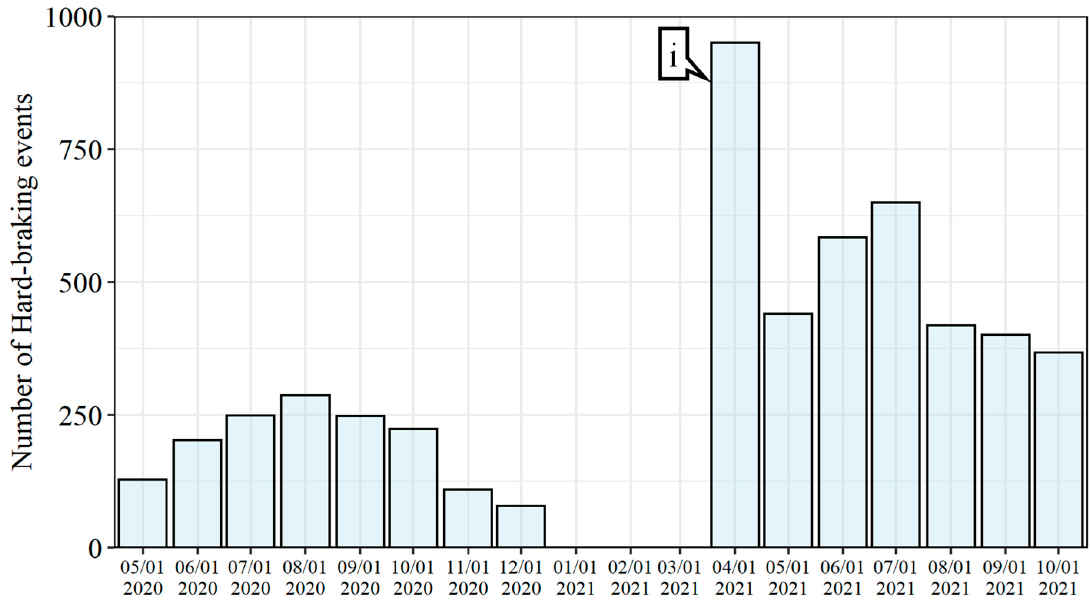
Figure 15. Interquartile speeds for 0.1-mile segments during and after the lane shift on I-65 NB. ( a ) Speeds during the lane shift (Monday, 12 April–Sunday, 18 April 2021); ( b ) Speeds after the lane shift (Monday, 3 May–Sunday, 9 May 2021).